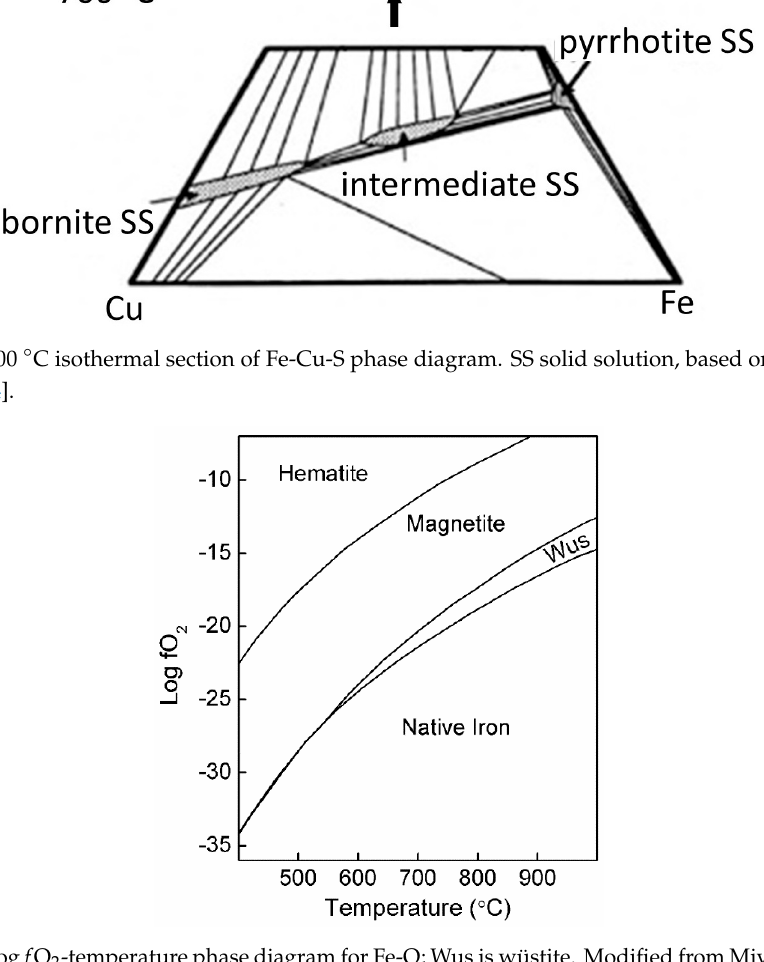
Figure 16. Log f O 2 -temperature phase diagram for Fe-O; Wus is wüstite. Modified from Miyashiro [52].